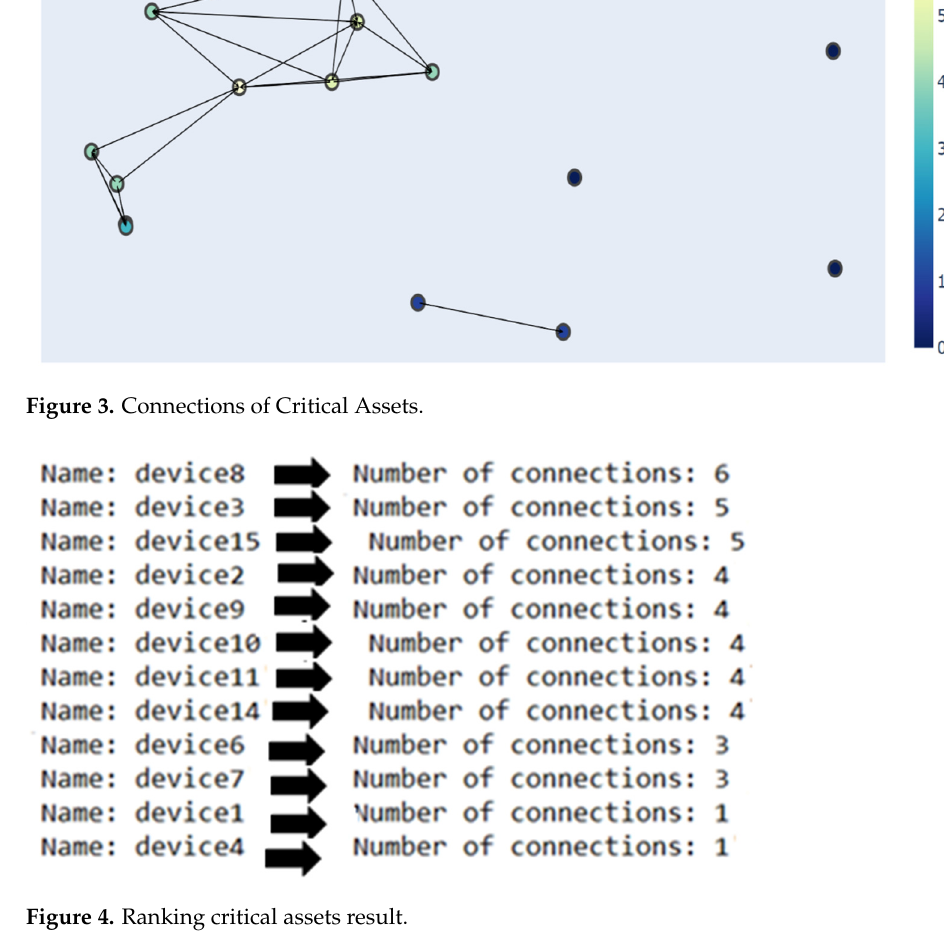
Figure 4. Ranking critical assets result.